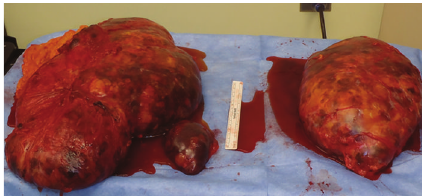
Figure 1: Axial and coronal views of the bilateral adrenal masses on computedtomographyimagingshowingaportionoftheleftadrenal mass interposed between the aorta and left adrenal vein bowing the vein anteriorly. Both masses are composed of broad sheets of fat, delicate septations, and isodense material. The bowel is displaced anteriorly and inferiorly but is showing normal bowel gas pattern.